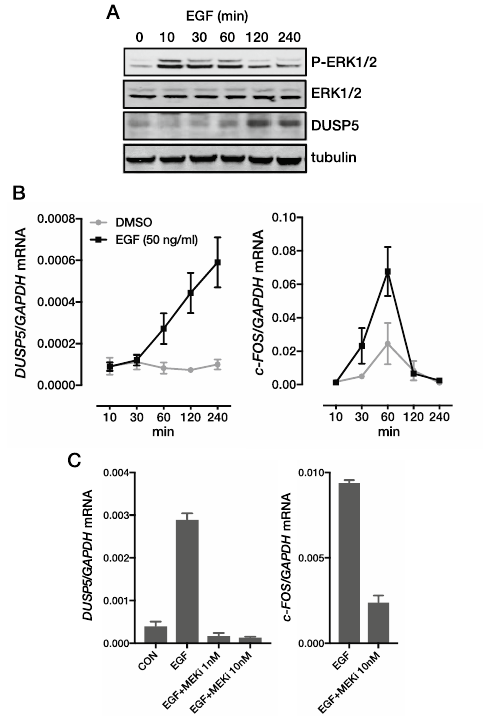
Figure 2. Induction of DUSP5 by EGFR-ERK signalling in CRC cells. Time-course showing EGF-mediated induction of ( A ) p-ERK1/2 and DUSP5 protein expression, and ( B ) DUSP5 and c-FOS gene expression in LIM1215 cells. ( C ) Induction of DUSP5 and c-FOS mRNA by EGF requires MEK/ERK signalling. LIM1215 cells were stimulated with EGF (50 ng/ml) for 24 h in the absence or presence of the MEK inhibitor (MEKi) trametinib. *P < 0.05, **P < 0.005, *P <